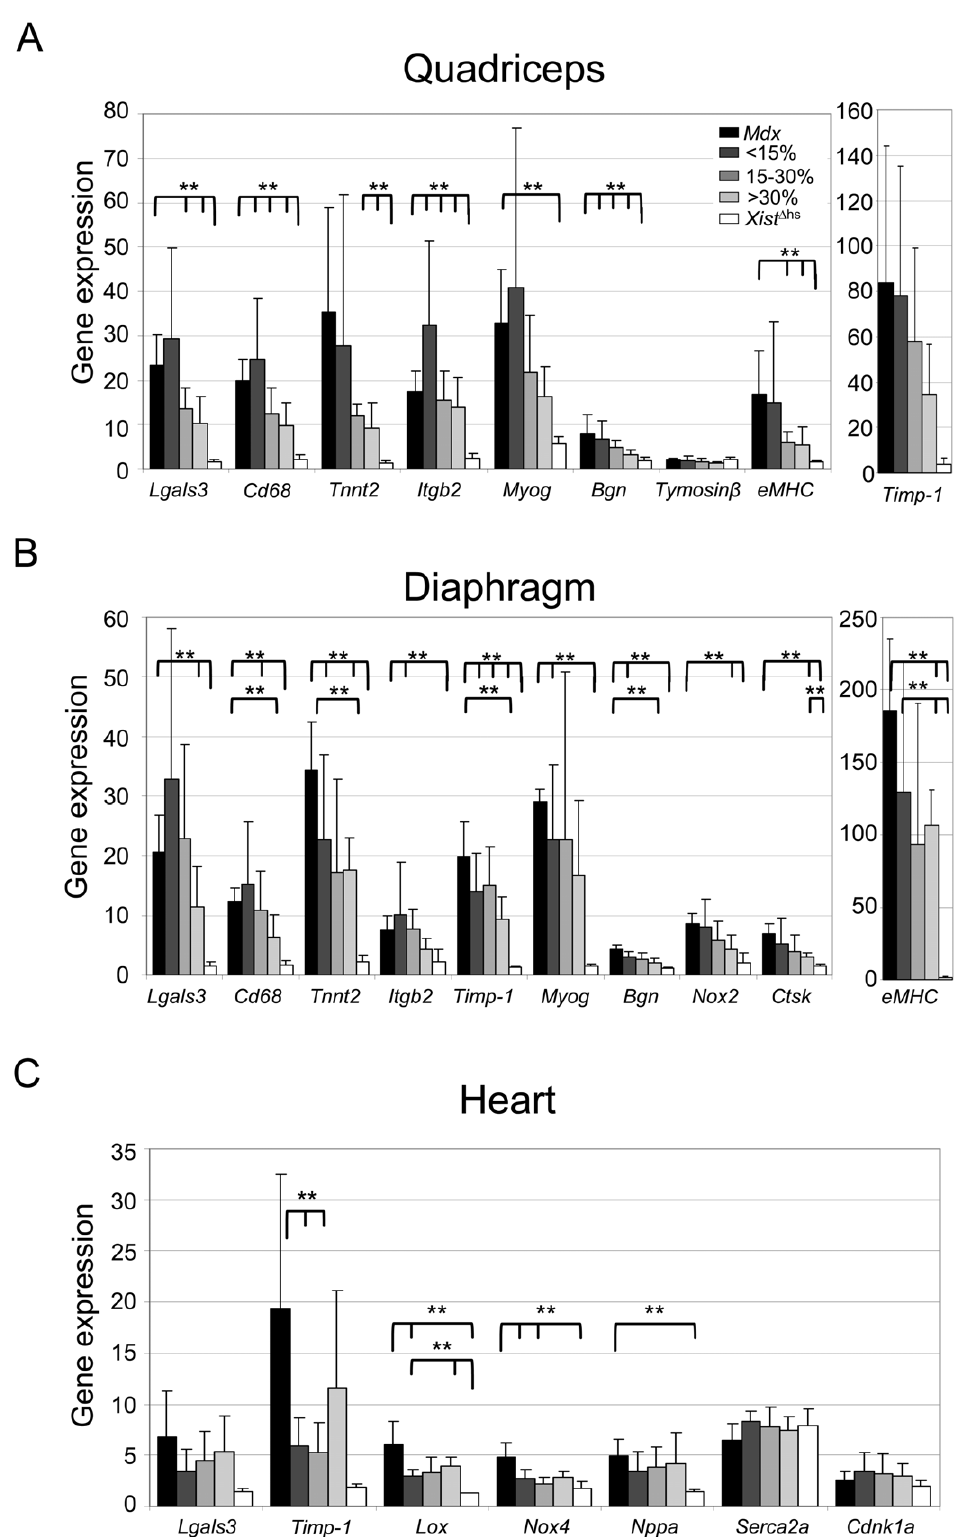
Figure 4. Expression of several genes involved in disease pathology. A and B. For most biomarkers a clear dystrophin level dependent restoration of gene expression levels was observed in the mdx-Xist D hs mice, where intermediate dystrophin levels resulted in low expression of genes involved in disease pathology. For some genes, dystrophin levels , 15% were enough to reduce gene expression while for other genes . 30% was necessary. C. In the heart, even dystrophin levels of , 15% decreased expression of fibrotic biomarkers like Timp-1 . Since the mice were young, no difference in expression levels in heart function was observed, except for Nppa . Double asterisks indicate a P , 0.01. doi:10.1371/journal.pone.0031937.g004 PLoS ONE |